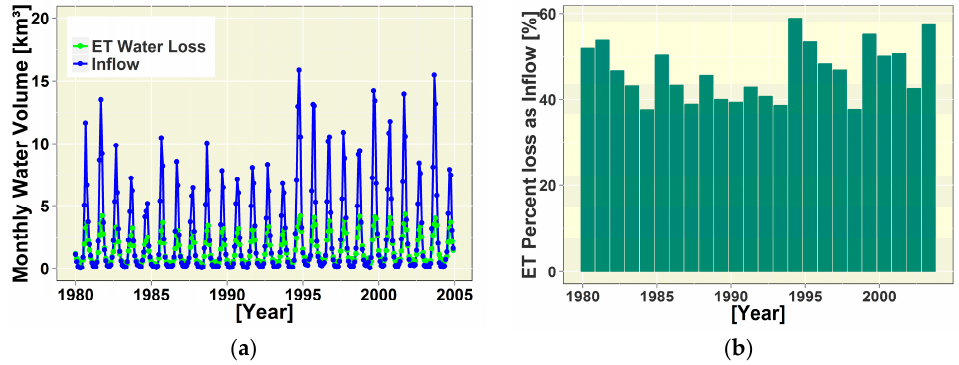
Figure 6. ( a ) Calculated evaporation (ET) losses in the Niger Inner Delta and combined river flows in KeMacina + Douna with values over the period 1980–2004; ( b ) Annual ET loss as a percent of the inflow in the NID.